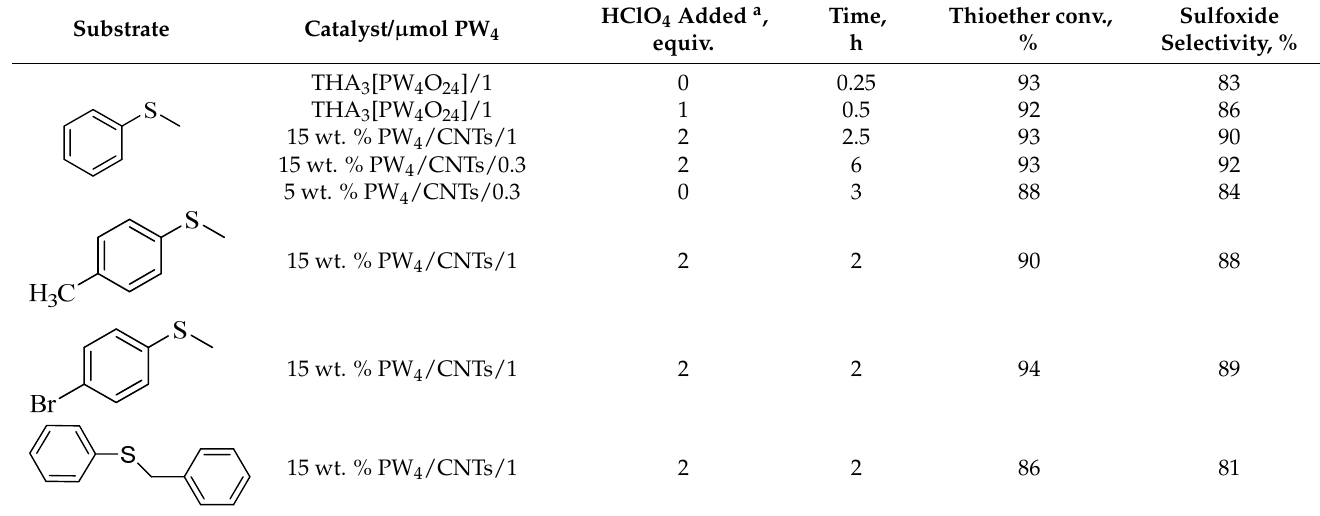
Table 8. Catalytic oxidation of various thioethers with H 2 O 2 over PW 4 /CNTs catalysts. Substrate